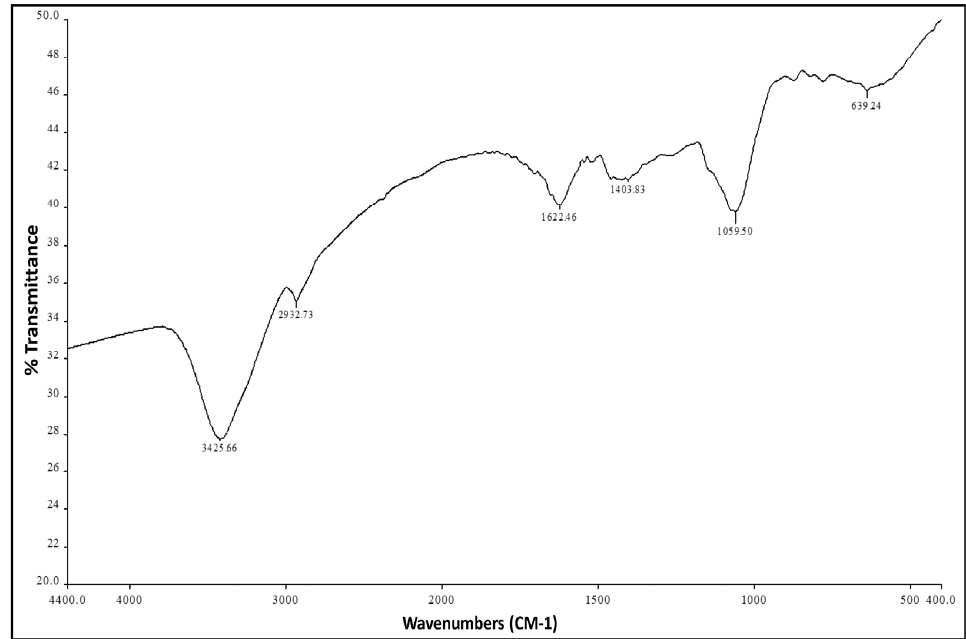
Figure 5. FTIR assay analysis of the water extract of T. aphylla. The results were produced by a Nicolet 6700 FT-IR Spectrometer in the range 500–4000/cm.